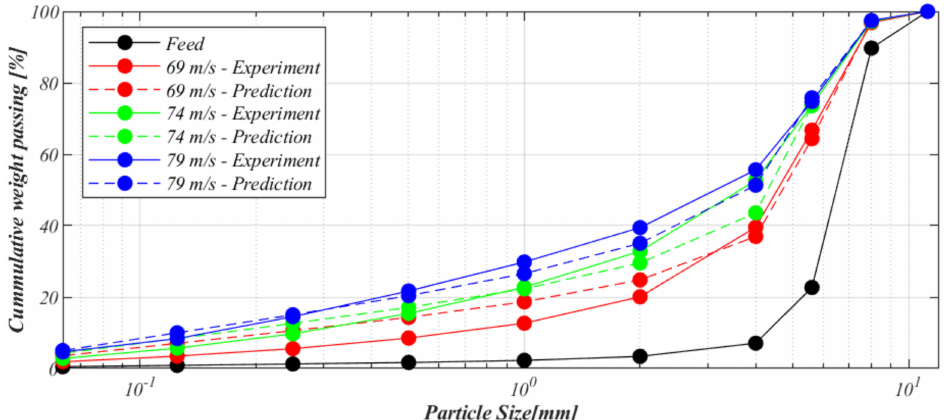
Figure 7. Particle size distributions from one of the sites and the corresponding simulation results. Case data are from Tierp, as seen in Table